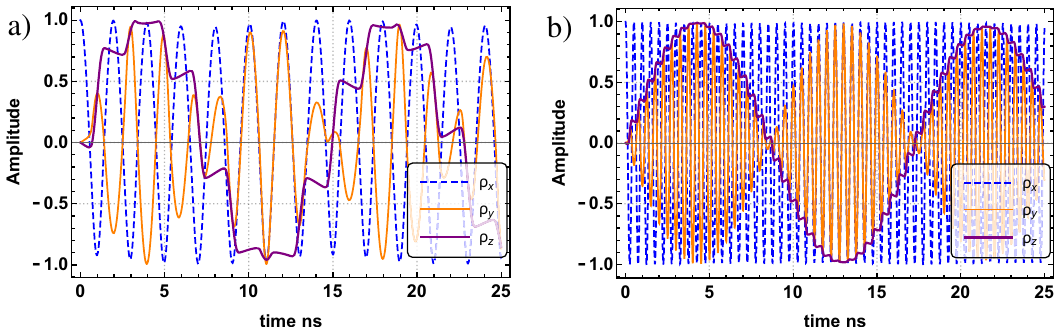
Fig. 5 Spin dynamics induced by nanomagnets. Evolution of 25 spins in the lab frame with the nanomagnet induced fi eld at 500 MHz drive a and 2 GHz drive b . The dashed-blue line indicates the average projection of 25 spins on x axis when they were initialized along the x direction. The red (purple) line indicates the average projection on z ( y ) axis for spins initialized in the y ( z ) direction. The effective ( π /2) x rotation happens at 3.871 ± 0.001 ns and 4.498± 0.001 ns in 500 MHz and 2 GHz drives, respectively. Spins rotate a π radian along the x -axis at 7.882 ± 0.001 ns and 8.998 ± 0.001 ns in 500 MHz and 2 GHz frequencies, respectively.